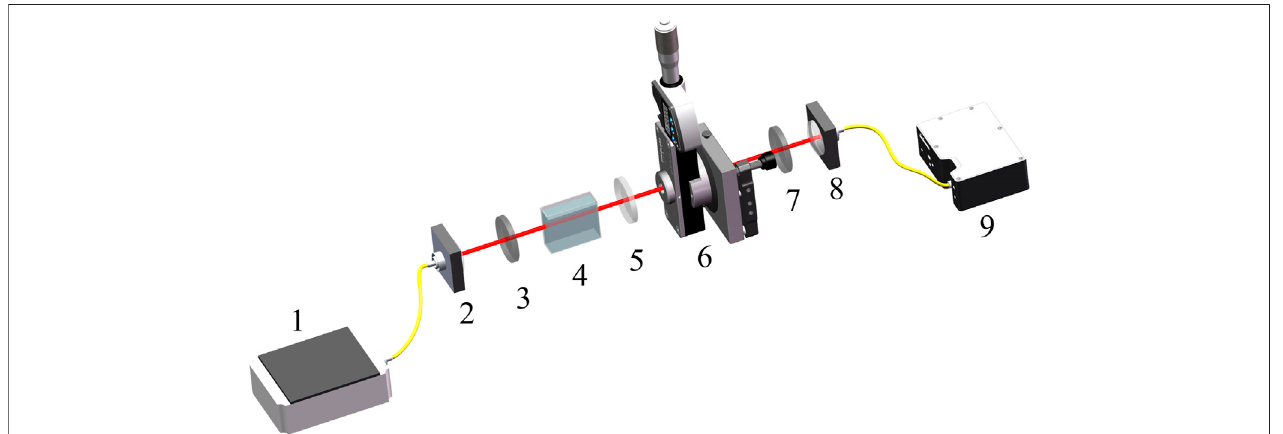
FIGURE 2 | Schematic installation of the weak measurement sensor. 1, Superluminescent laser diode (SLD, IPSDD0804, 5 mW, Center wavelength: 840 nm, bandwidth: 40 nm, Inphenix). 2 and 8, Collimating and coupling lenses. 3 and 7, Pre- and post-selection polarizer (Thorlabs Inc., 180 LPVIS050-MP, extinction ratio of 100,000:1). 4, Sample Cell. 5, Achromatic Quarter Wave Plate (Thorlabs Inc., AQWP05M-980). 6, Soleil-Babinet Compensators (SBC, Thorlabs Inc., SBC-IR). 9, Spectrometer (Ocean Optics,